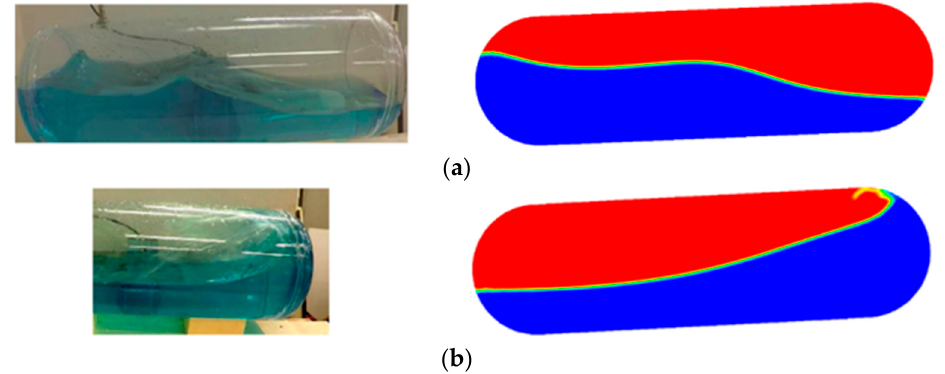
Figure 5. Comparison of interface shape between experimental and simulation results. ( a ) Case 2; ( b ) Case 3.